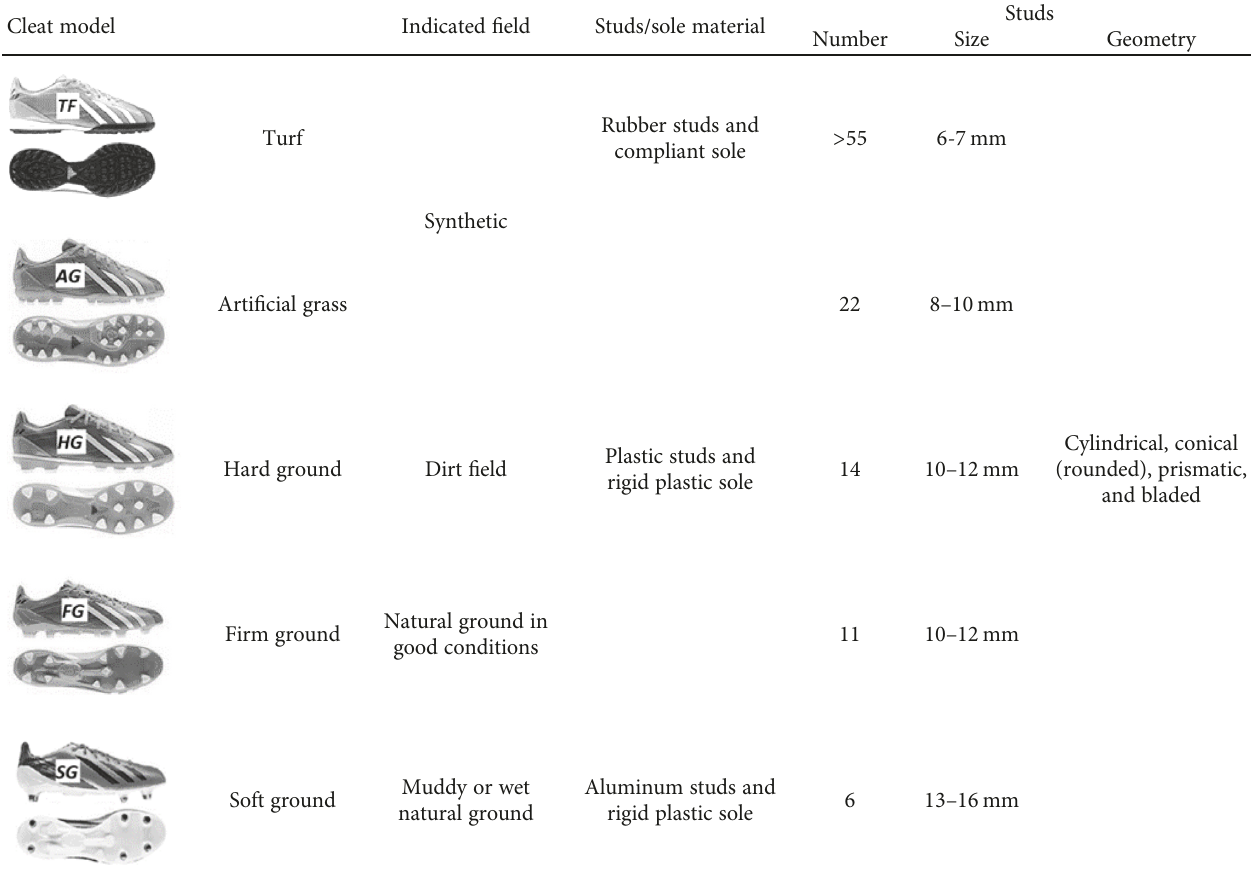
Table 1: Cleats ’ characteristics.